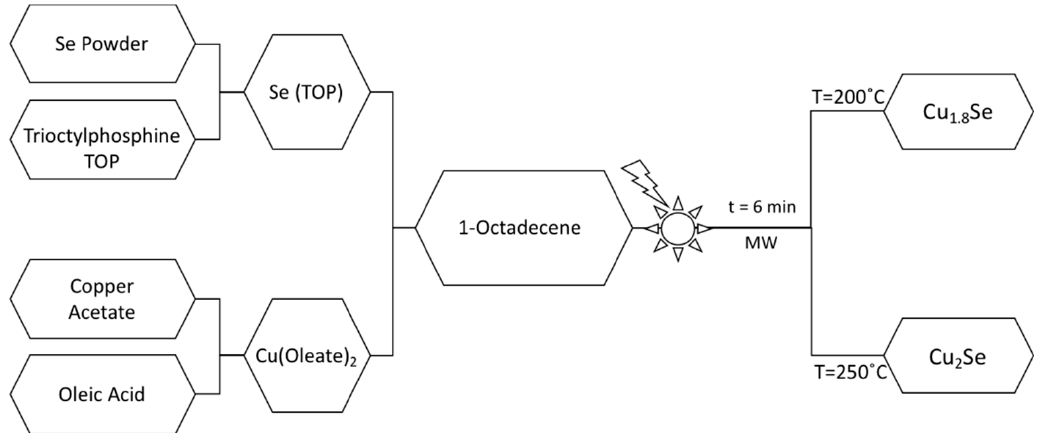
Figure 1. Schematic description of the microwave (MW)-assisted synthesis process of Cu 2 − x Se.